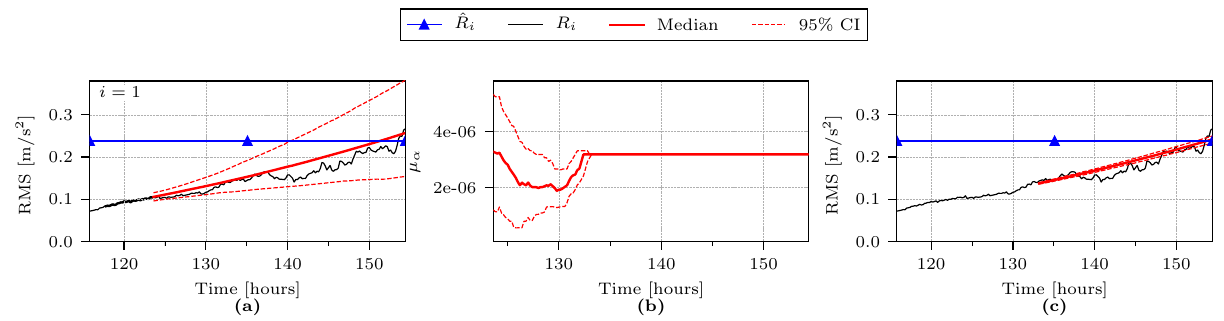
[4000, 4400] Hz; (d) R 11